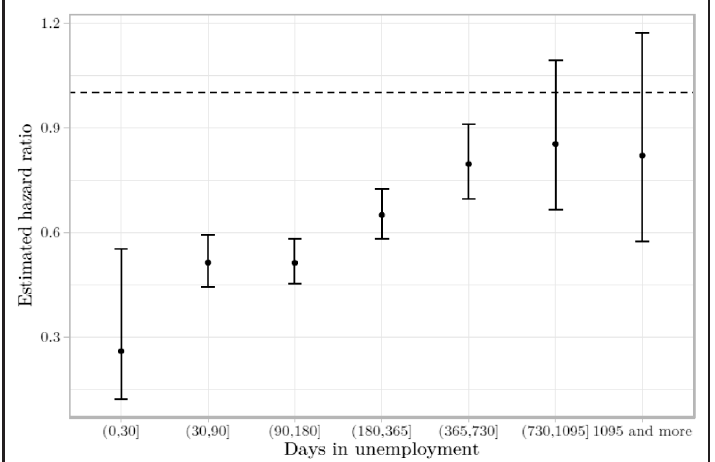
Heterogeneous effects: time spent at the unemployment